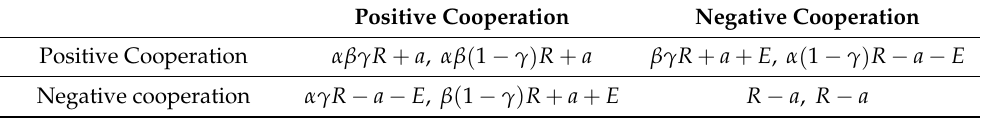
Table 1. Green technology innovation cooperation game income matrix for construction